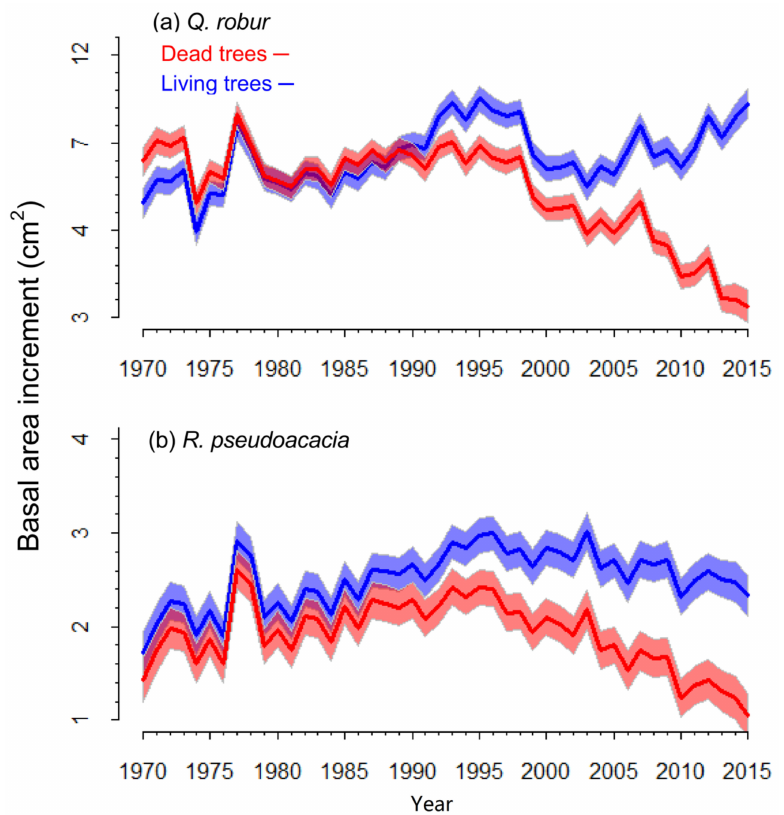
Figure 3. Predicted basal-area increment (log x+1 transformed data) for living (blue lines and areas) and recently dead trees (red lines and areas) of ( a ) oak ( Quercus robur ) and ( b ) black locust ( Robinia pseudoacacia ). Predictions are based on Generalized Additive Mixed Models (see Table 2). Lines and areas represent the predicted means and their standard errors, respectively.